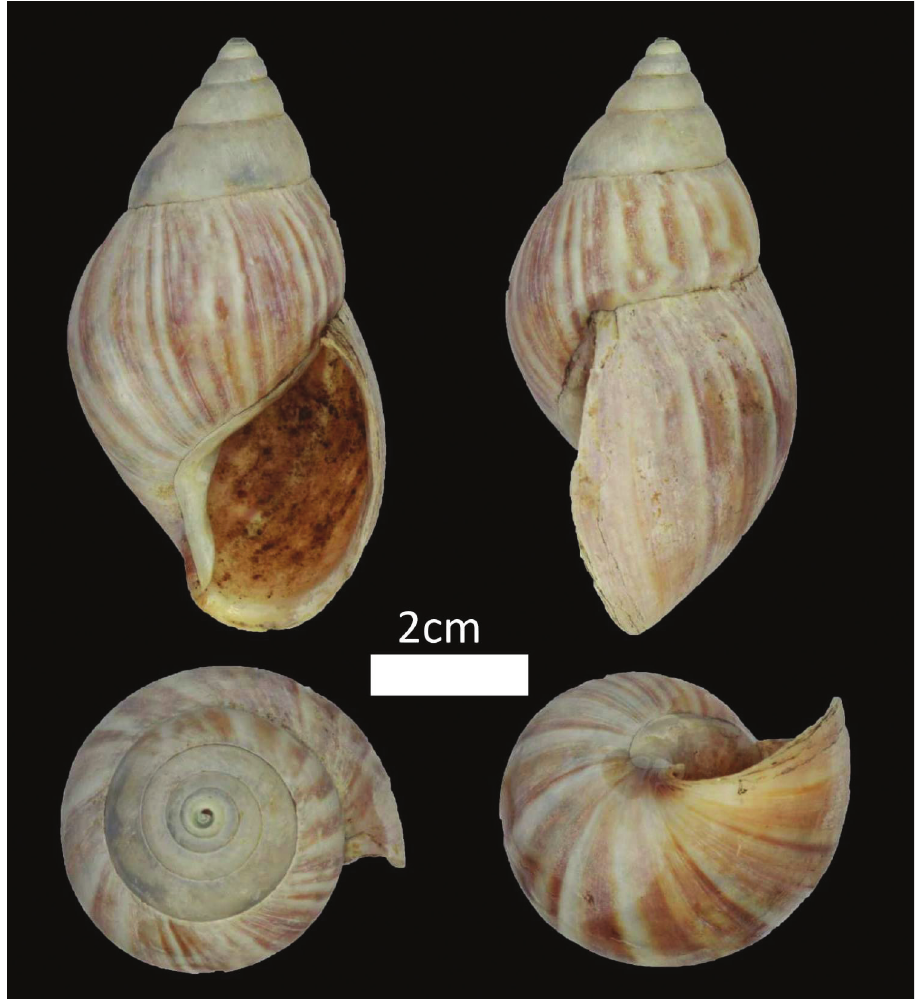
Figure 10. Family Achatinidae. Achatina fulica (BOR/MOL 12339). 6639, BOR/MOL 6640, BOR/MOL 6647, BOR/MOL 6649, BOR/MOL 6672, BOR/MOL 6676, BOR/MOL 6680, BOR/MOL 6682, BOR/MOL 8483, BOR/ MOL 8485, BOR/MOL 8490, BOR/MOL 8506, BOR/MOL 8513, BOR/MOL 8522, BOR/MOL 8849, BOR/MOL 8853, BOR/MOL 8854, BOR/MOL